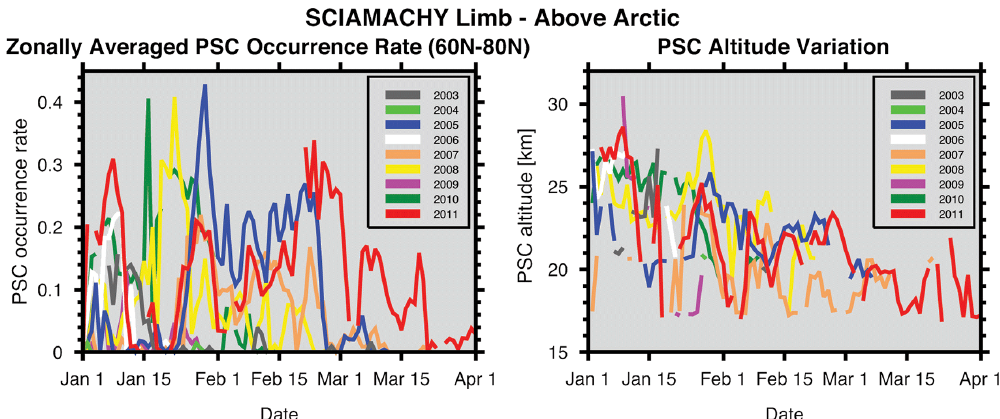
Fig. 9. PSC occurrence rate (a) and PSC altitude (b) obtained from SCIAMACHY limb observations since 2003. For clarity reasons only years with frequent PSC occurrences are displayed in the right